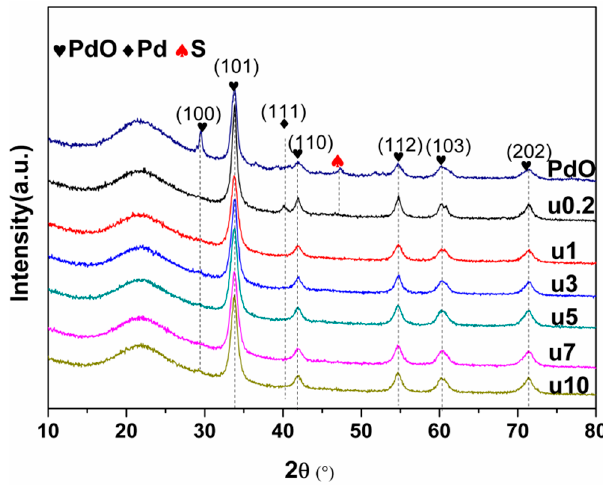
Figure 5. XRD patterns of used catalysts with different H 2 S concentration.